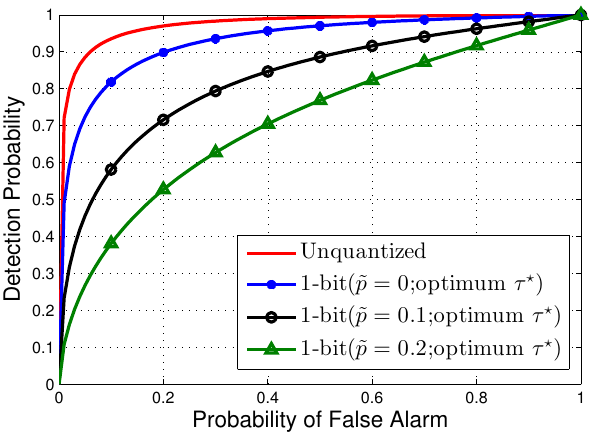
Figure 4. ROC curves of the proposed one-bit GLRT in BSC channels, when N = 5